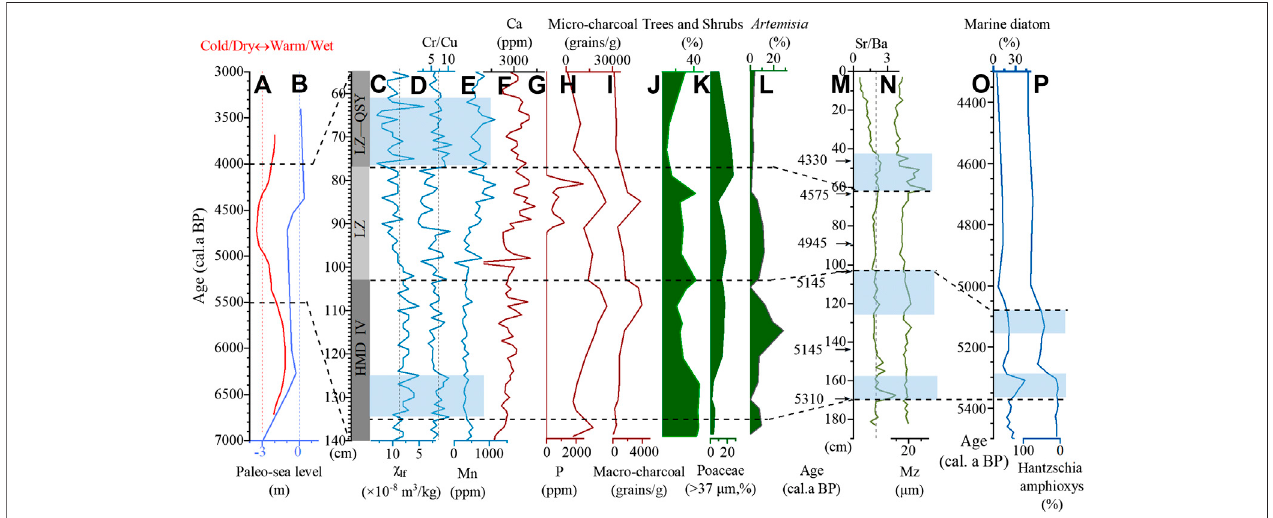
FIGURE 6 | Records of the study area: (A) the climate fl uctuation curve on the south bank of the Yangtze River Delta (Chen et al., 2005), (B) the relative sea-level change in the study area (Wang et al., 2018),and (C) – (L) χ lf , Cr/Cu, Mn, Ca, P, micro-charcoal, macro-charcoal concentrations, Tree and Shrubs percentage, Poaceae ( > 37 μ m)and Artemisia percentage,respectively(thisstudy). (M) – (N) meangrainsize(Mz)and Sr/Baratiosinpro fi leT0103WoftheXiawangduSite(Huangetal.,2021). (O) – (P) the abundances ofmarine diatoms and the aerophilic freshwater diatom Hantzschiaamphioxysinpro fi le T0602W ofthe Xiawangdu Site (He et al.,2020a).